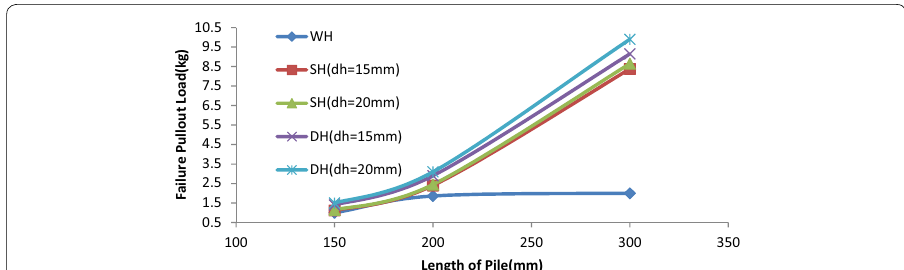
Fig. 20 Variation of failure pullout load with length and helix diameter of helical